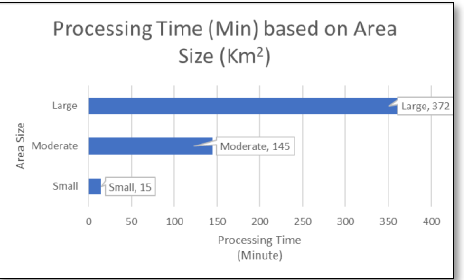
Figure 8: Comparison between processing time based on area